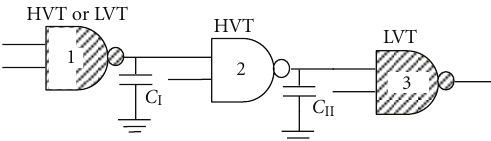
Figure 5: Situation of HVT cell to calculate the limSlew . Figure 6: Situation of the LVT cell not changed for the calculation of limSlew .